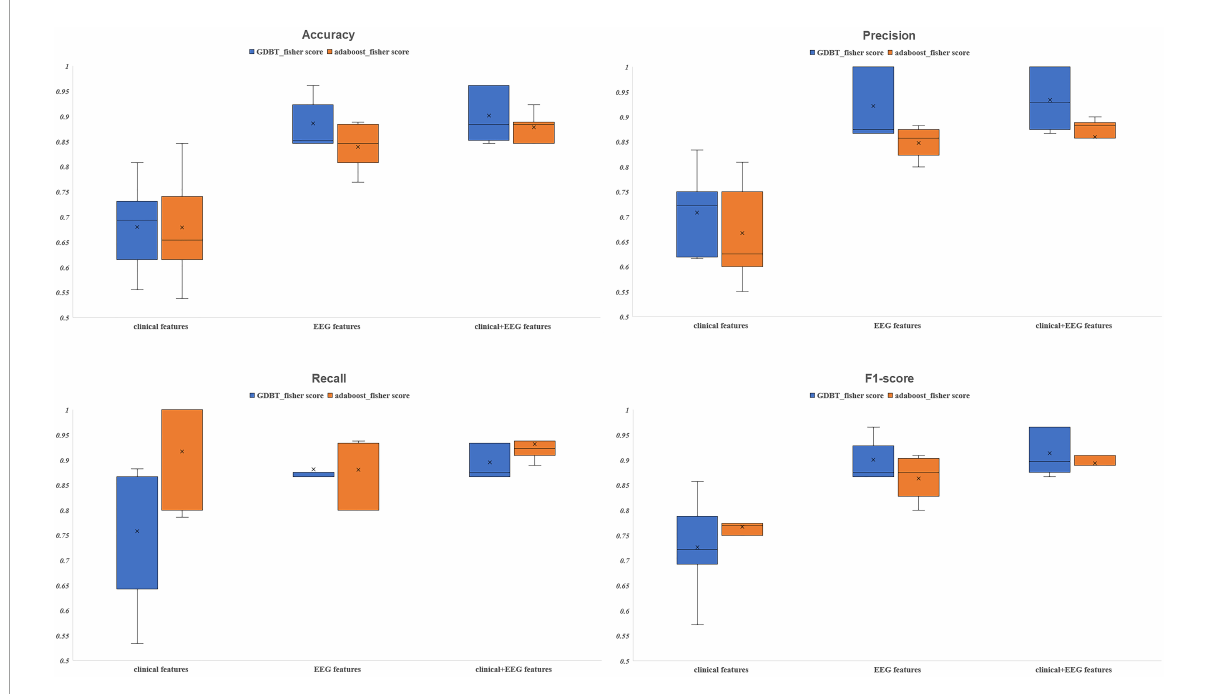
FIGURE3 The evaluation indexes after five-fold cross-validation. GBDT, Gradient Boosting Decision Tree; AdaBoost, Adaptive Boosting.